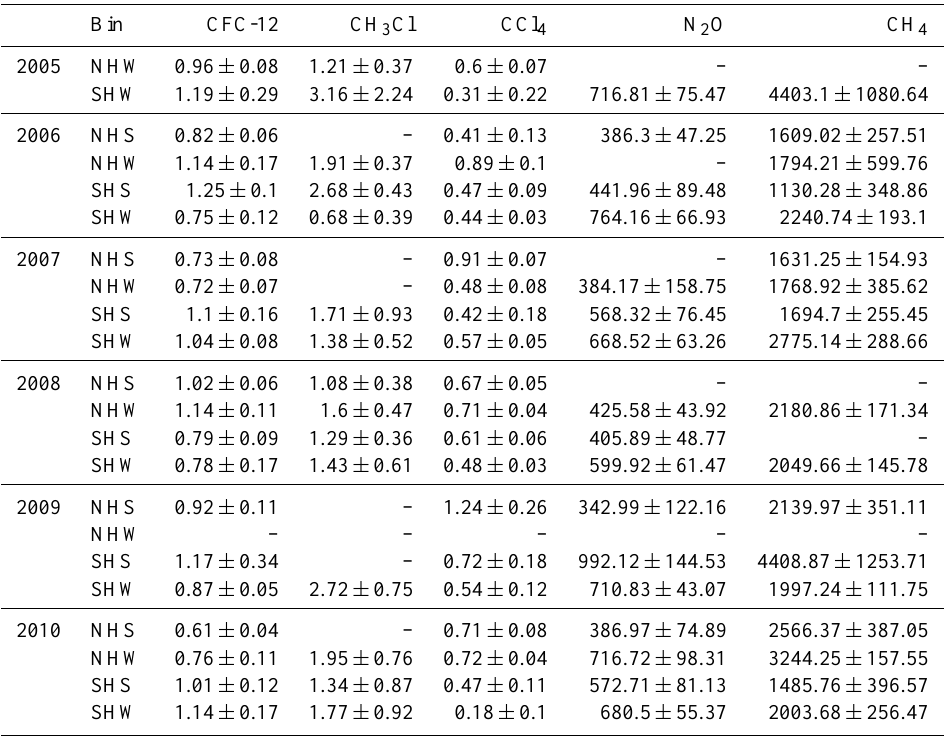
Table A1. The slopes of the correlations of CFC-12, CCl 4 , CH 4 , CH 3 Cl and N 2 O with CFC-11, extrapolated to the tropopause. NHS is Northern Hemisphere summer, NHW is Northern Hemisphere winter, SHS is Southern Hemisphere summer, SHW is Southern Hemisphere winter. Data with errors greater than the correlations have been removed.